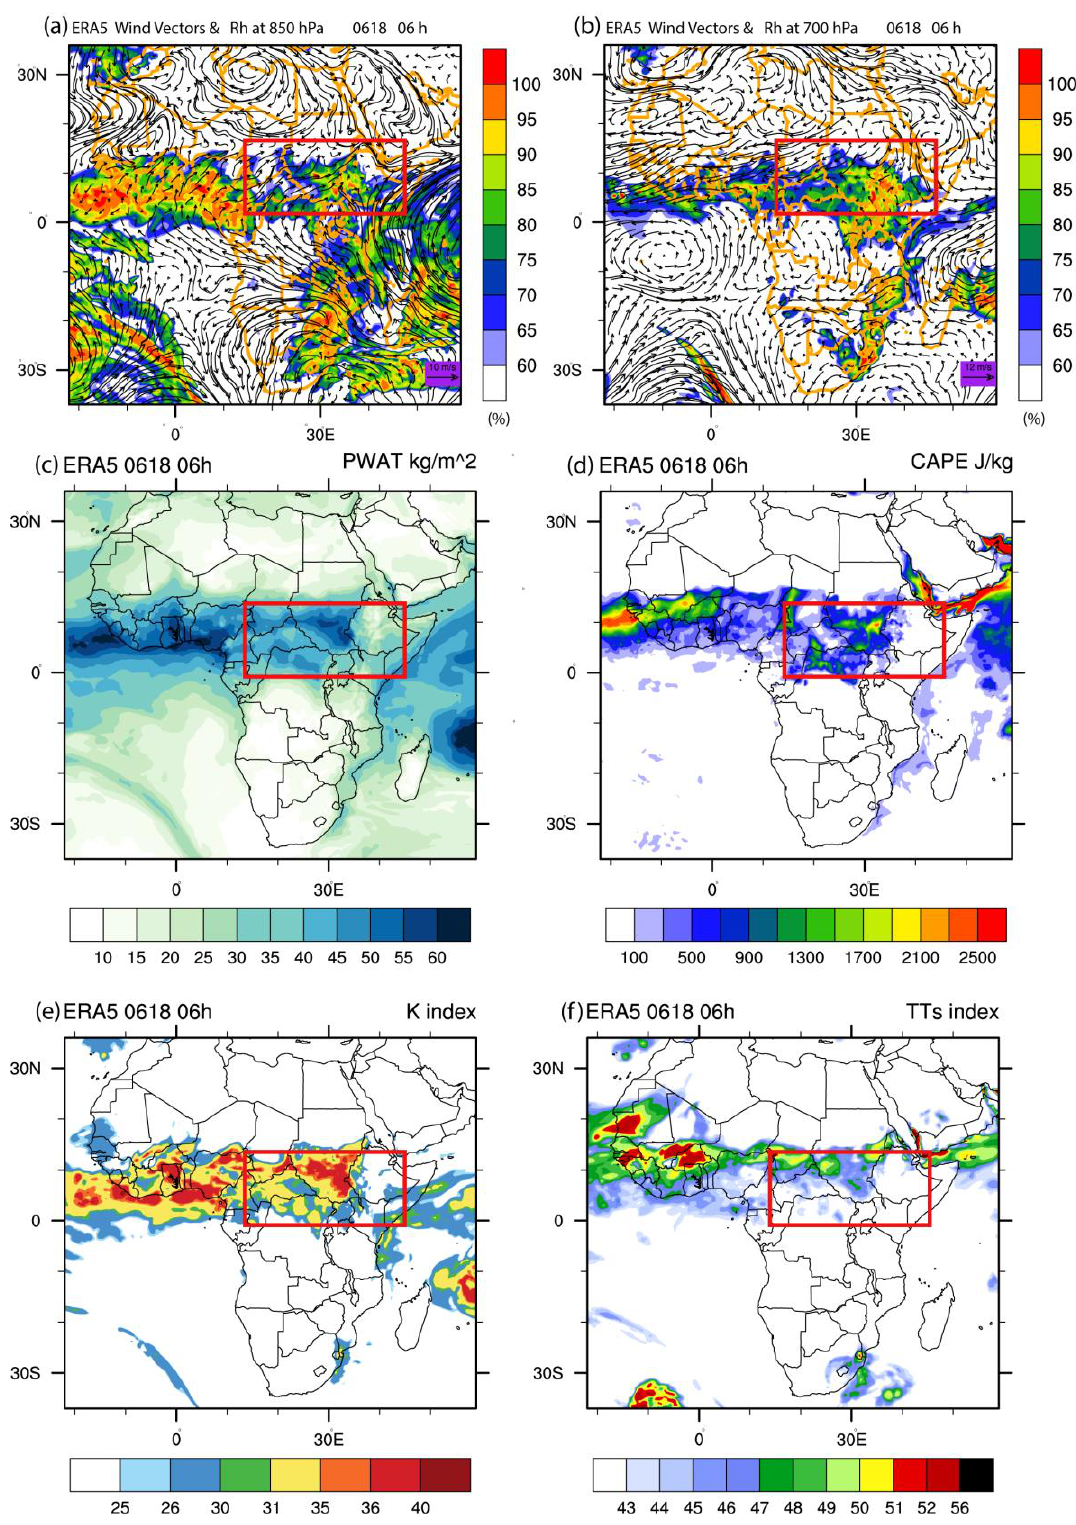
Figure 13. Synoptic analysis of ERA5 data at 6am (UTC) on 18 June 2020. ( a ) wind at 10 m (m/s; vectors) and relative humidity (%; shaded) at 850 hPa; ( b ) wind (m/s; vectors) and relative humidity (%, shaded) at 700 hPa; ( c ) precipitable water (kg/m 2 ); ( d ) convective available potential energy (J/kg); ( e ) K-index; and ( f ) total of totals index. The red box denotes the ROI (South Sudan–Ethiopia